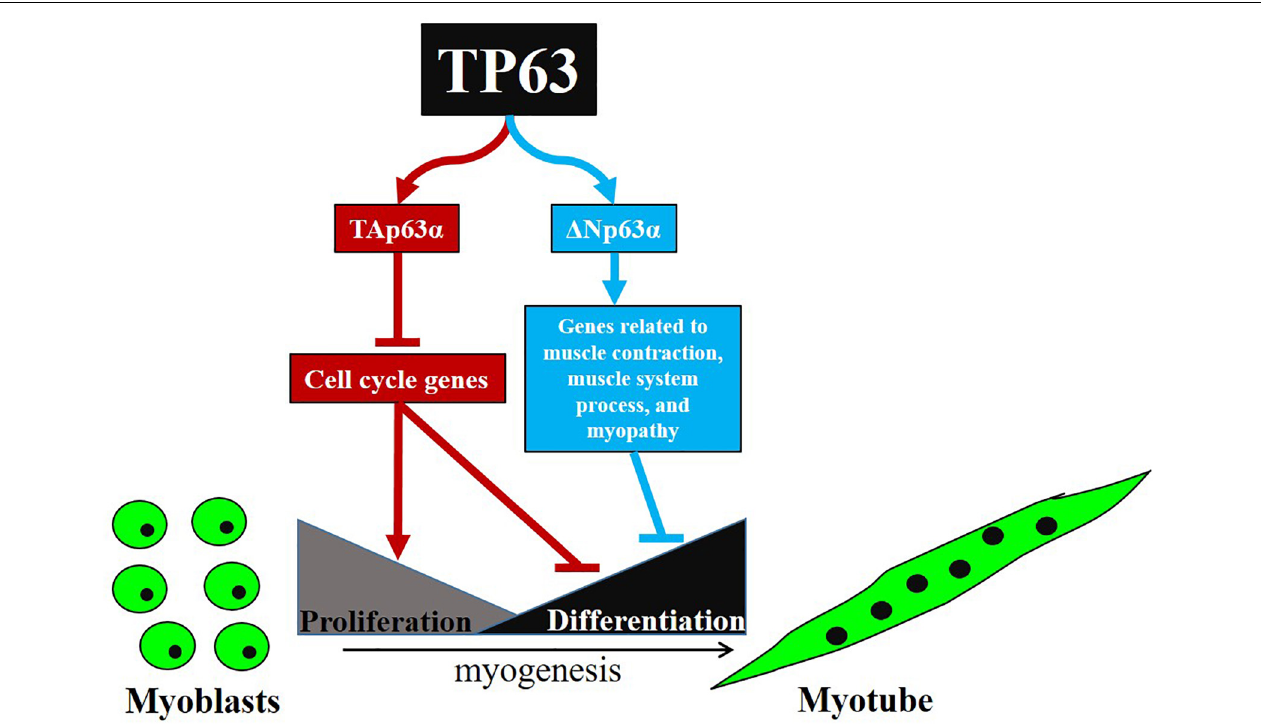
FIGURE 6 | Schematic illustration for signaling pathways of myoblast proliferation and differentiation regulated by TP63 gene.